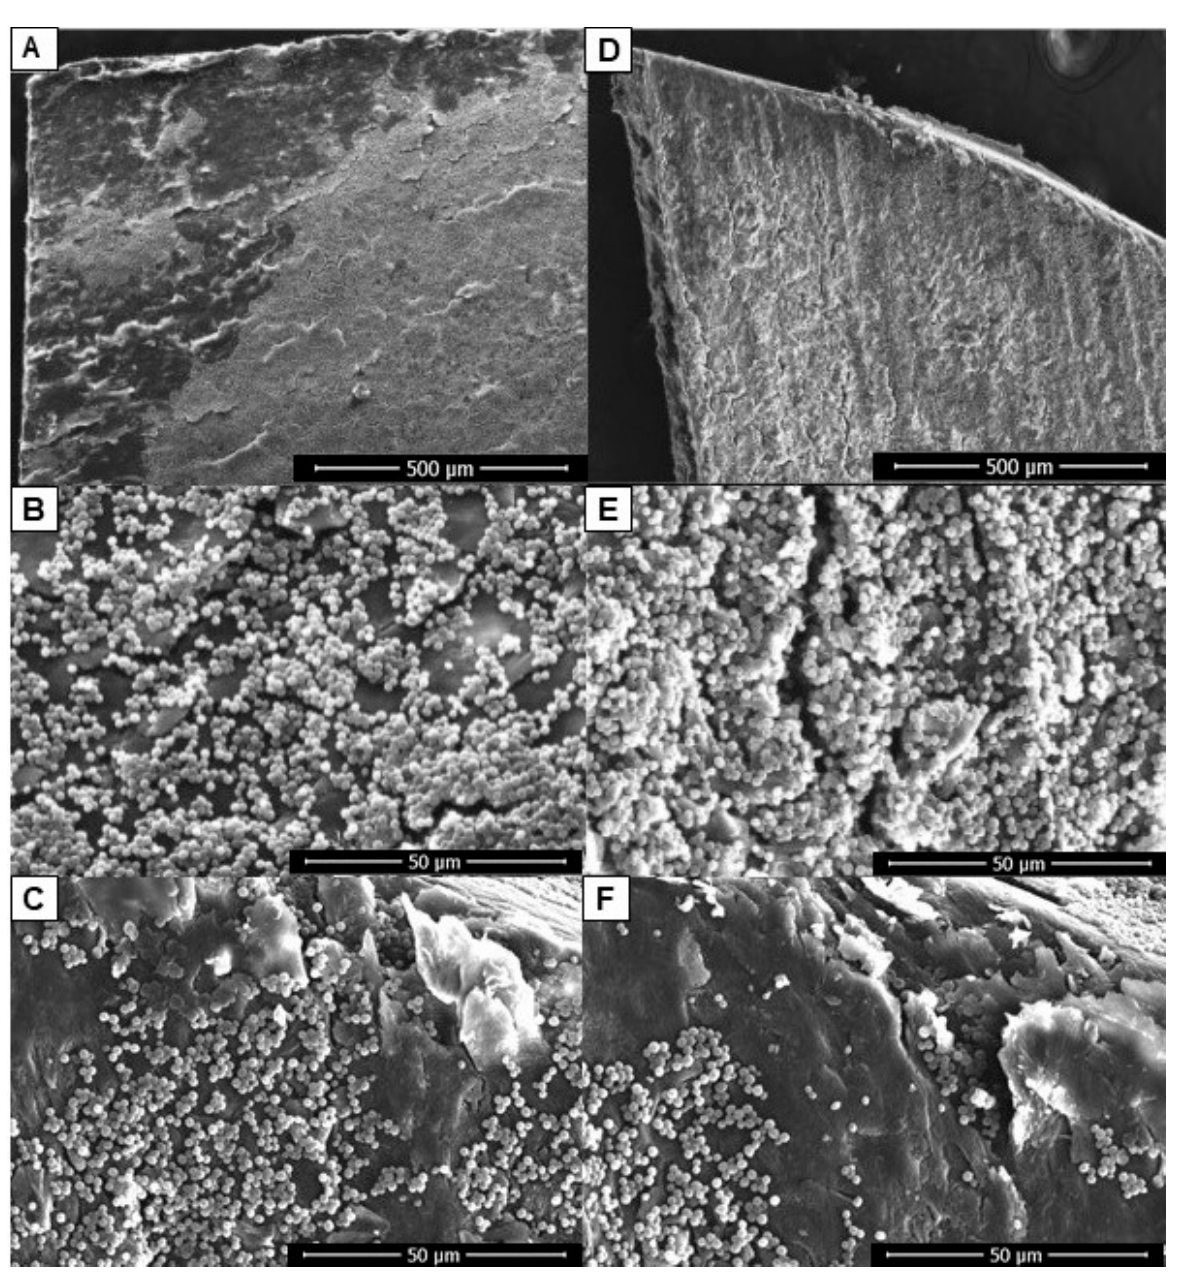
Figure 2. Biofilms of C. albicans on the nail’s surfaces in an ex vivo model of onychomycosis: dorsal ( A , B , and C ) and ventral ( D , E , and F ). SEM images showing the more intense and organized de- velopment of the fungus when applied on the ventral surface ( D and E ) in contrast to the more discreet growth on the dorsal surface ( A and B ). Intense yeast growth in the fissures present on the nail surfaces ( C and F ). Scale bar = 500 μ m ( A and D ); scale bar = 50 μ m ( B , C , E , and F ).